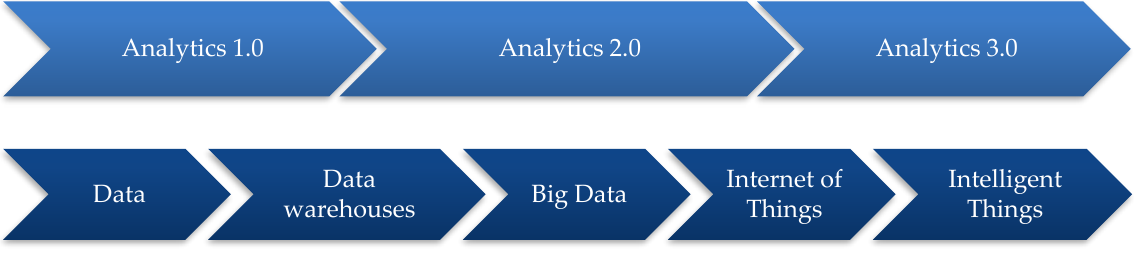
Figure 2. Analytics continuum. Source: own elaboration.